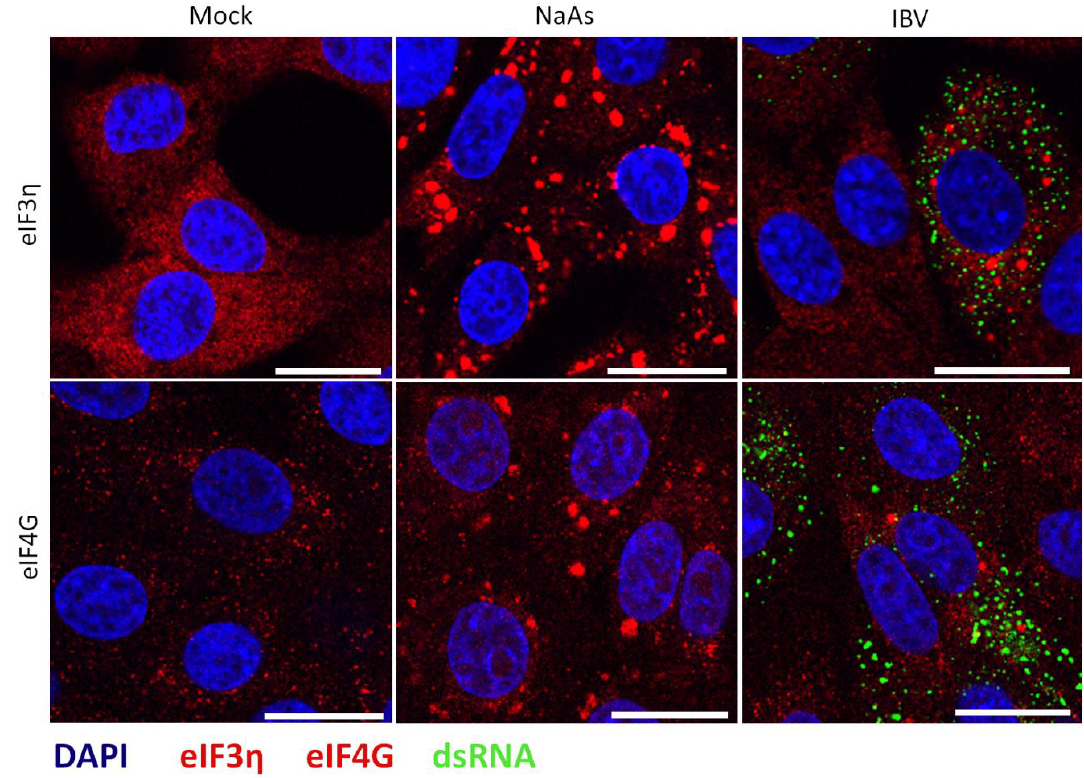
Figure 3. IBV induced stress granules contain multiple stress granule markers. Vero cells were mock infected or infected with IBV. One hour prior to fixation, where indicated cells were treated with sodium arsenite (NaAs). At 24 hpi, cells were fixed and labelled with dsRNA (green) and anti-eIF3η (red) or eIF4G (red), Nuclei were stained with DAPI (blue). Scale bars indicates 20 µm. Images are representative of three independent repeats.